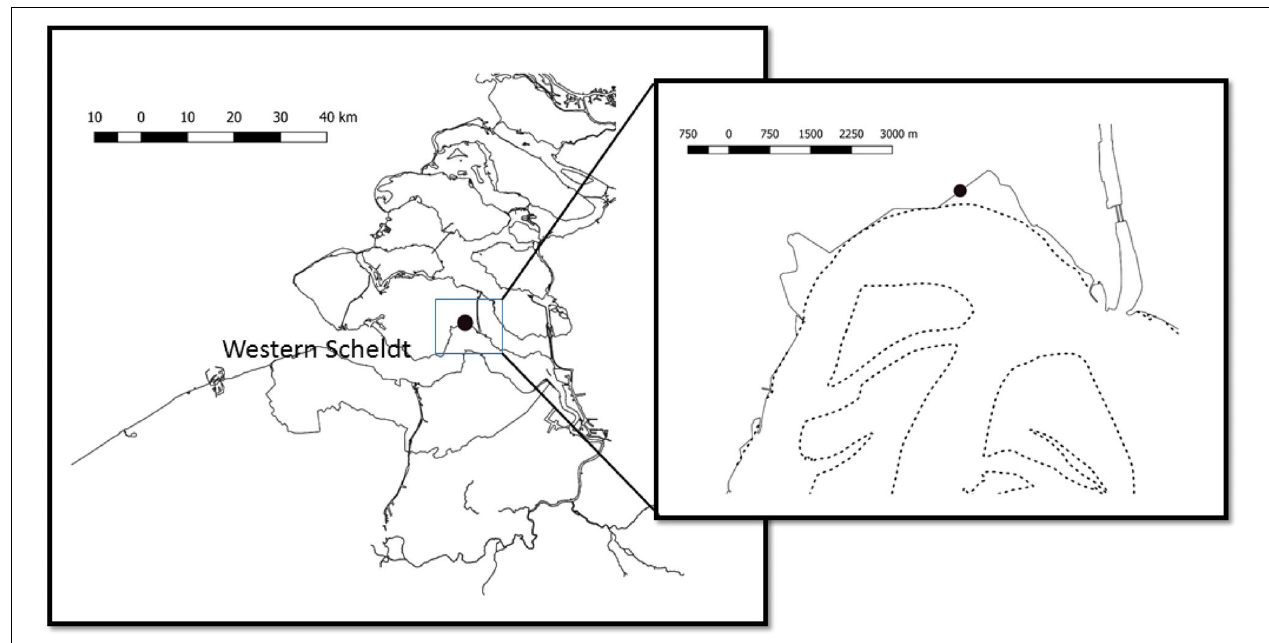
FIGURE 1 | Location of the study site at the Kapelle Bank within the Westerschelde (Western Scheldt) estuary in the south-west of Netherlands. The dotted lines show the mean low tide line delimiting intertidal flats.